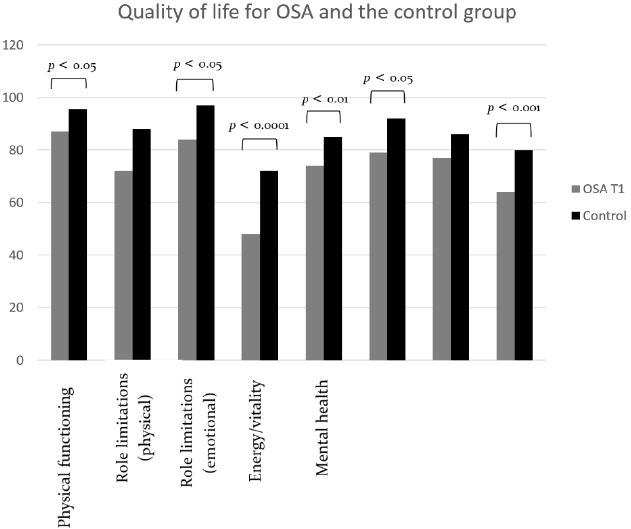
Figure 3. Differences in quality of life between the OSA group and the control group before (T1) MAD treatment. Significant differences are shown with lines and p values.